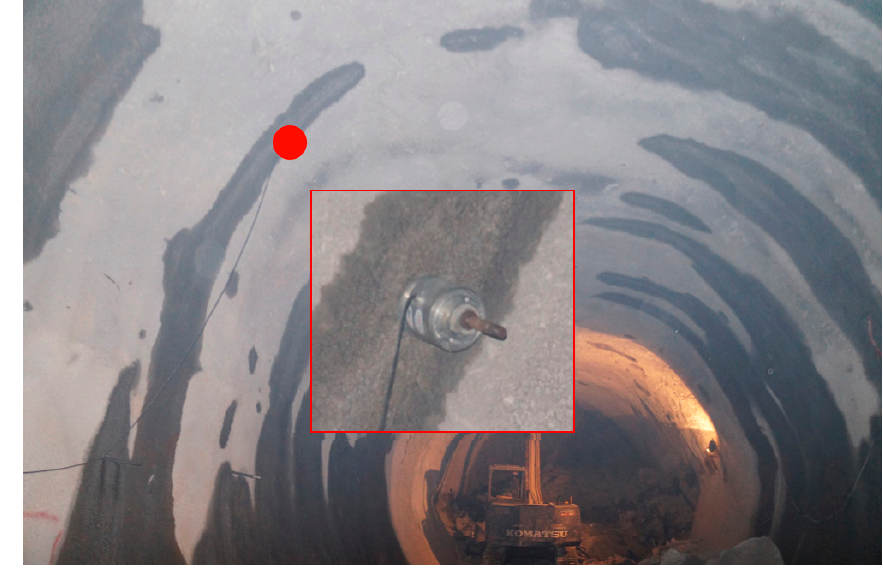
Figure 10. Field deployment of the monitoring point.